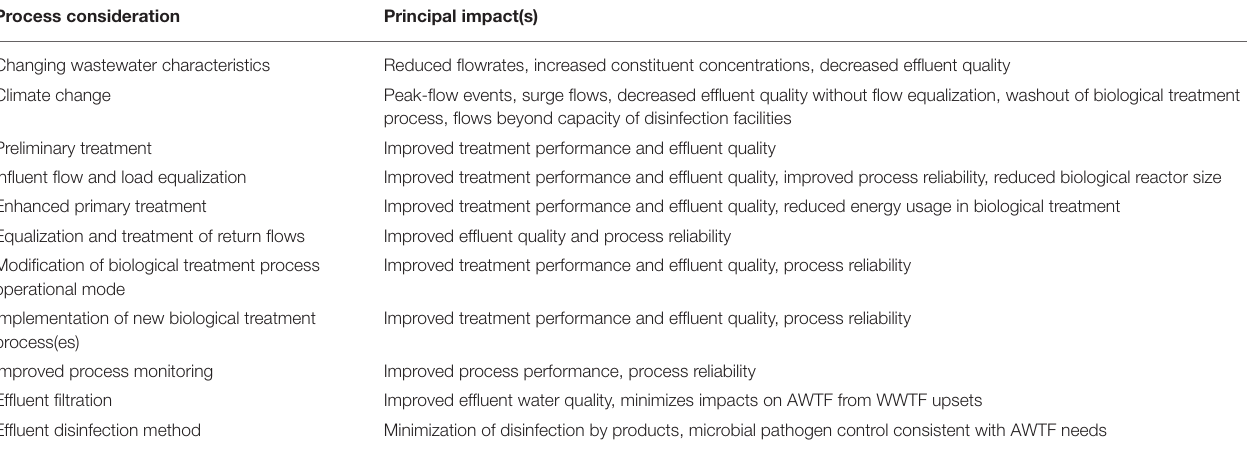
TABLE 1 | Factors, measures, and operational strategies that must be considered in optimizing the performance of wastewater treatment facilities producing an effluent to be treated further in an advanced water treatment facility for potable reuse a